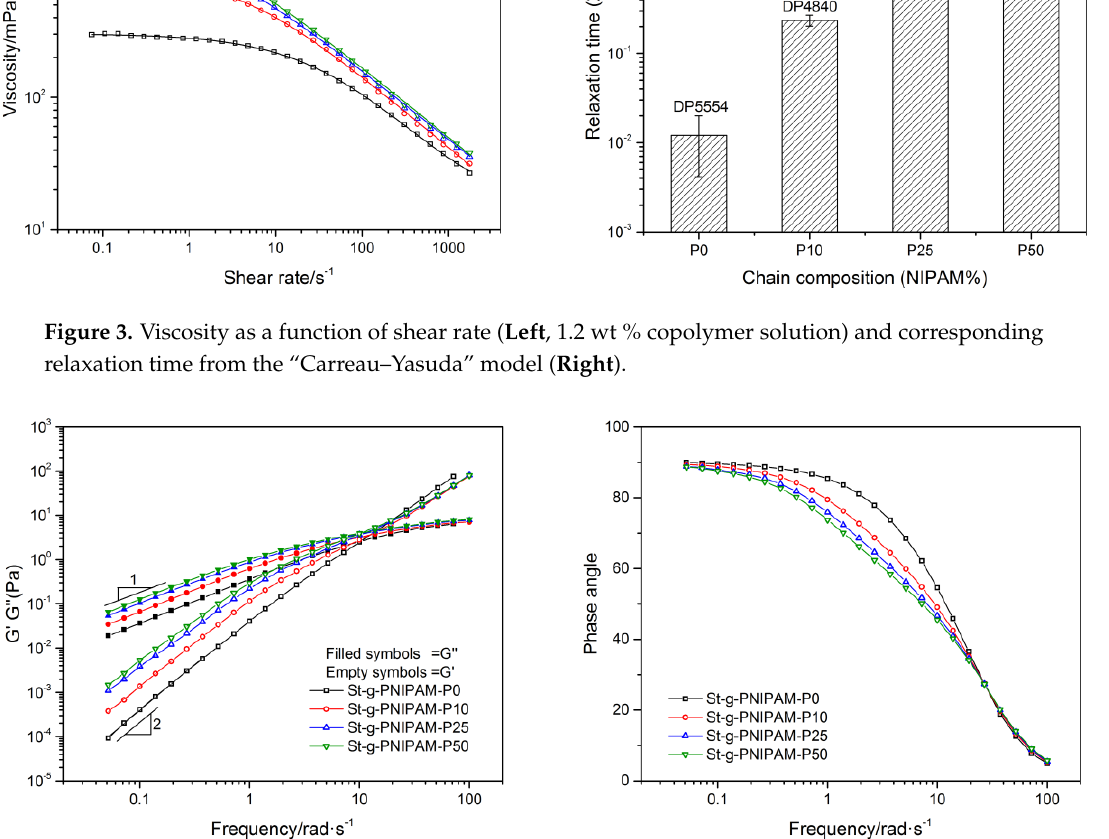
Figure 4. The storage (G′), loss storage (G′′) ( Left ) and phase angle ( Right ) as a function of frequency at 1.2 wt % copolymer concentration.